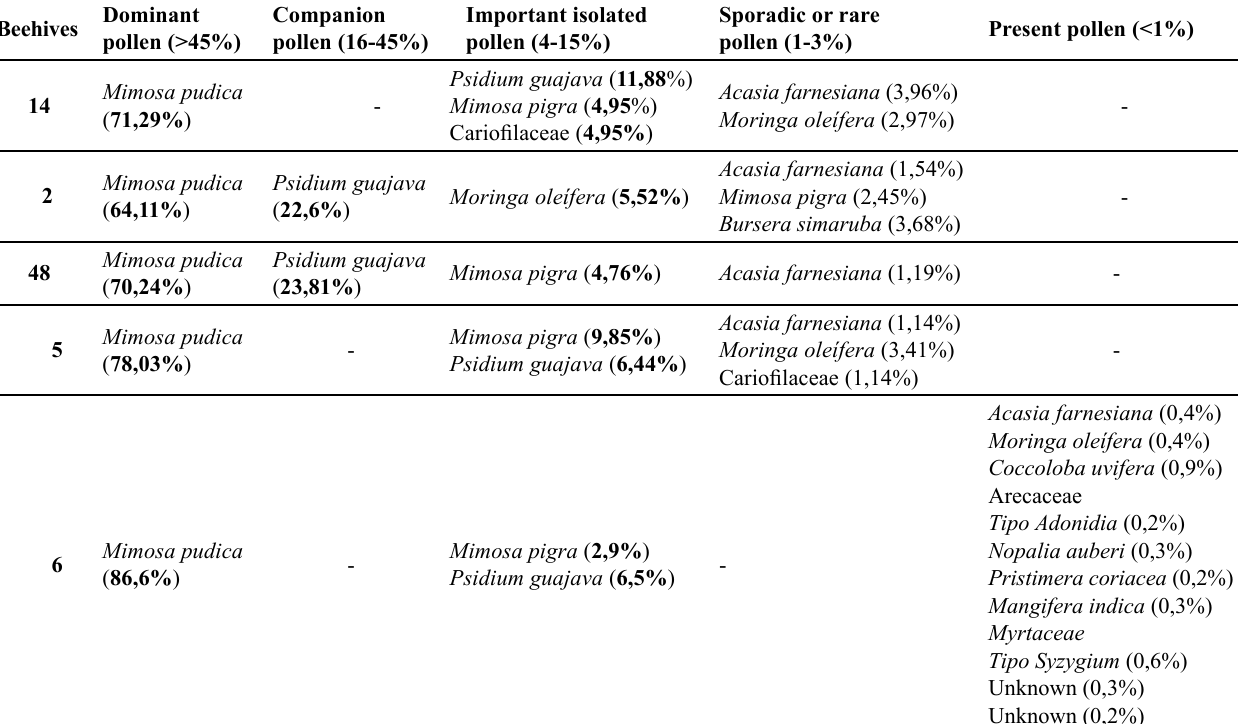
Table 4. Pollen types identified in the honeys from Mayabeque beehives. Dominant Beehives pollen